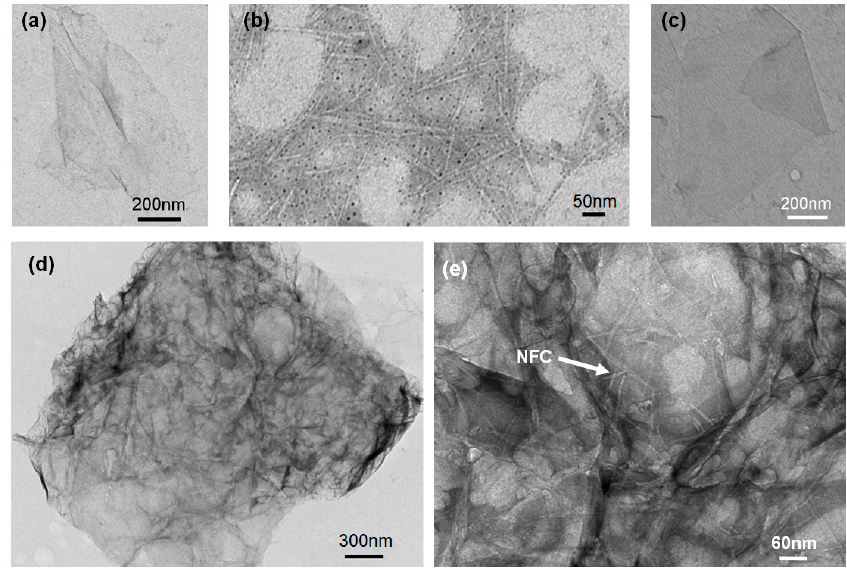
Figure 3. Transmission electron microscopy (TEM) images (100 kV) of ( a ) graphene; ( b ) nanofibrillated cellulose (NFC); ( c ) graphene oxide (GO); and ( d , e ) NFC-graphene-GO.